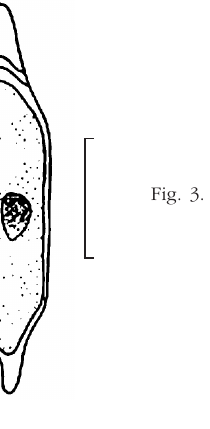
3. – Egg. Scale-bar: 10